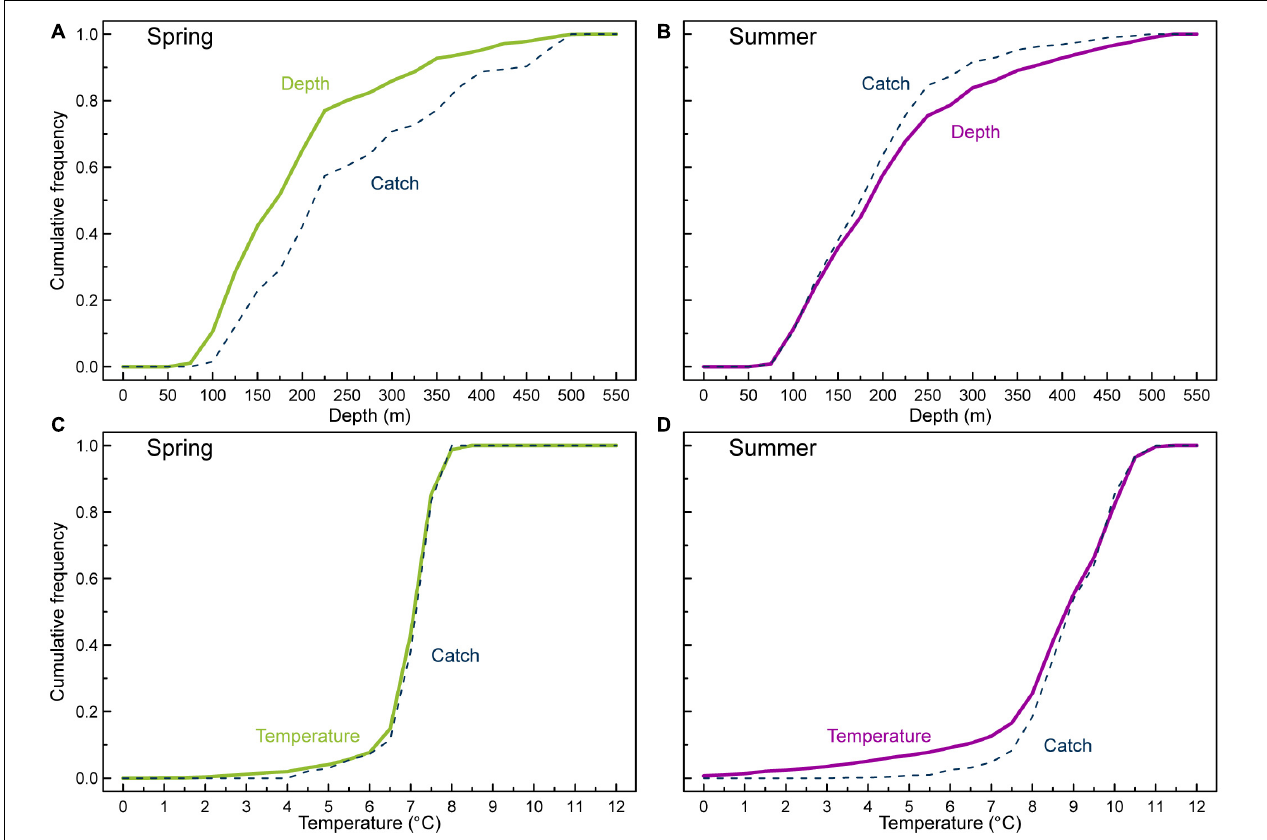
FIGURE 5 | Cumulative frequency distribution of depth and temperature together with anglerfish catch weighted functions from the Faroe Plateau surveys for spring (A,C) and summer (B,D)